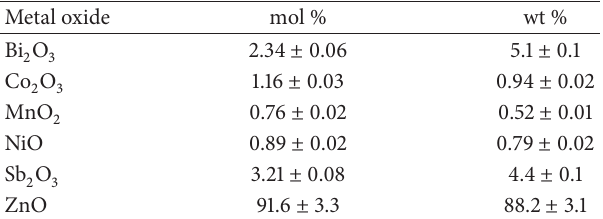
Table 1: Chemical composition of